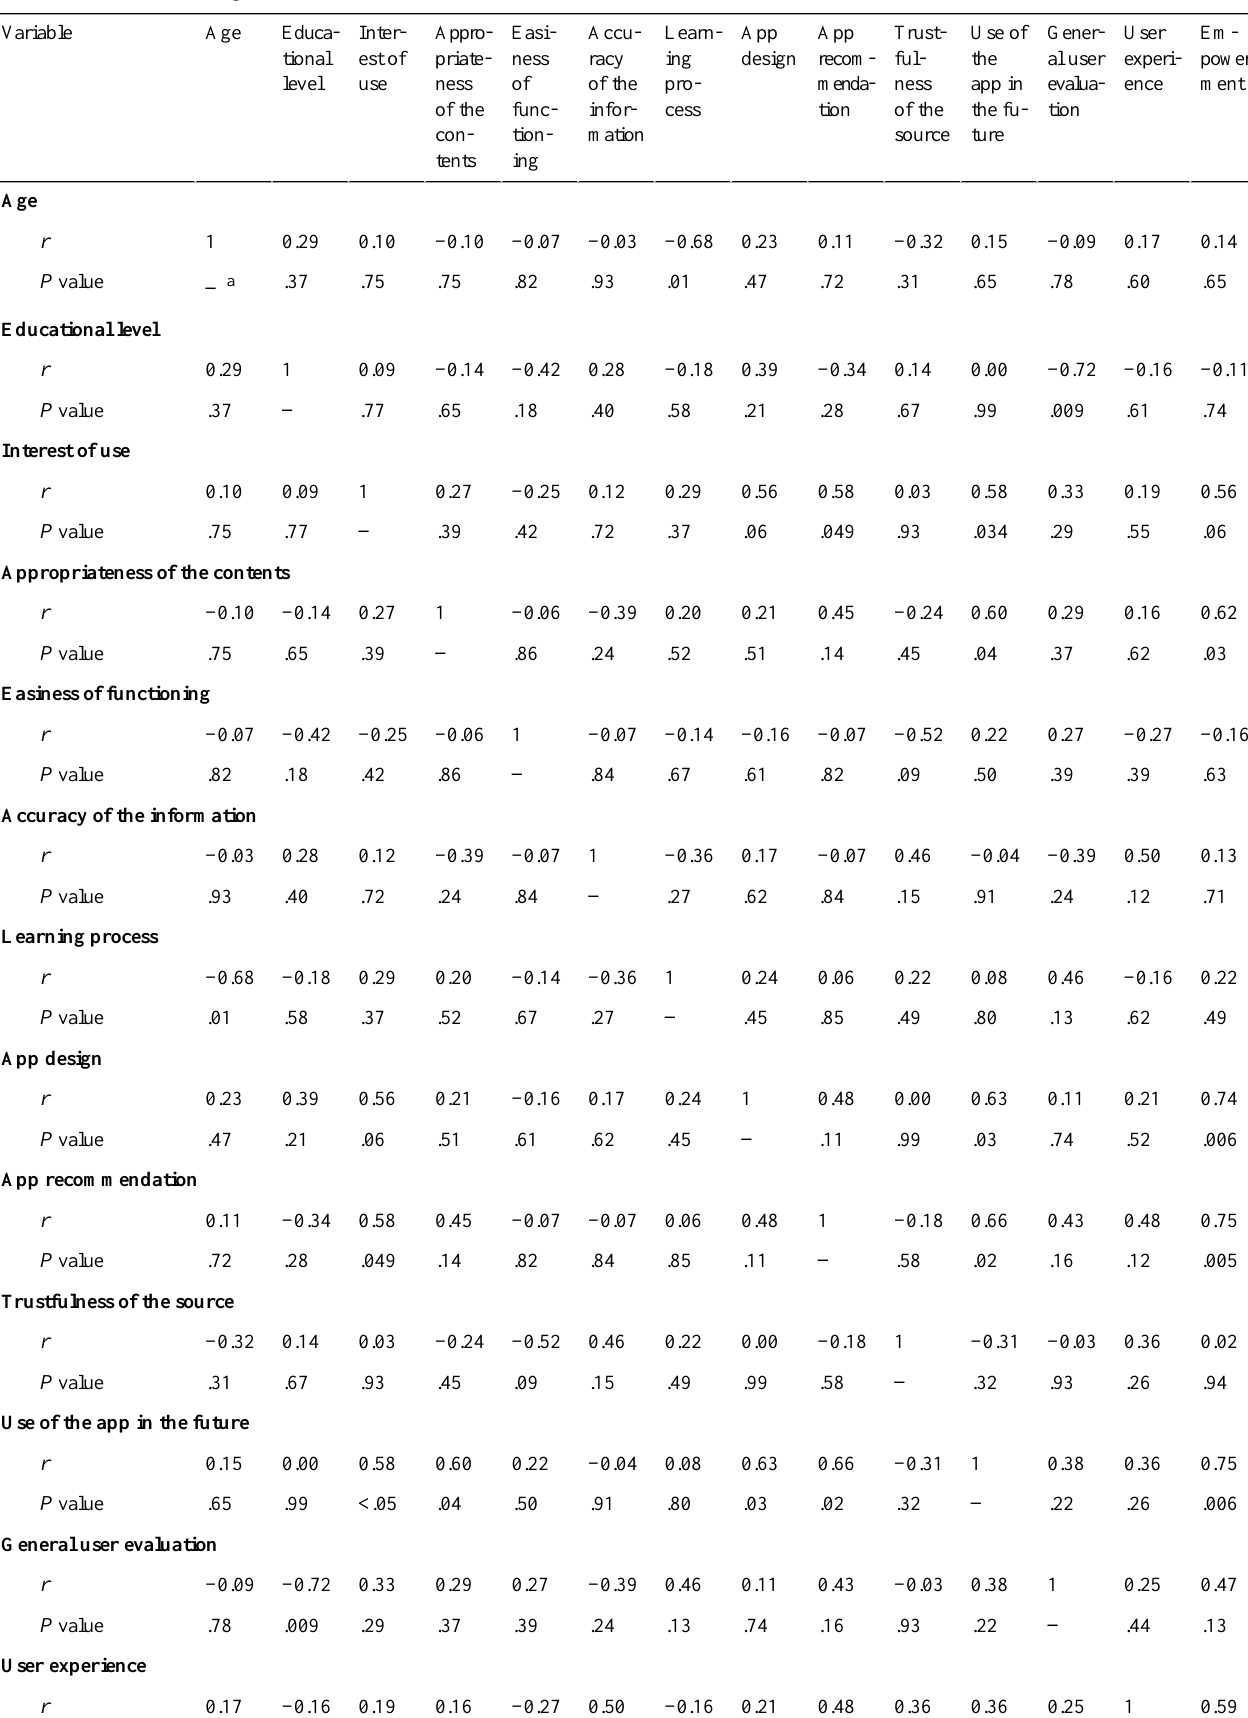
Table 3. Correlations among the variables.